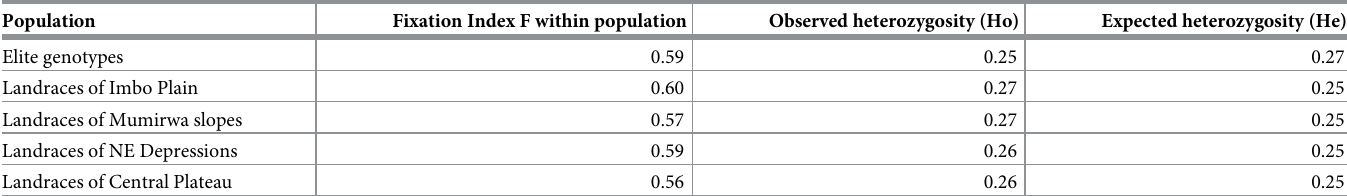
Table 5. Fixation index and heterozygosity within